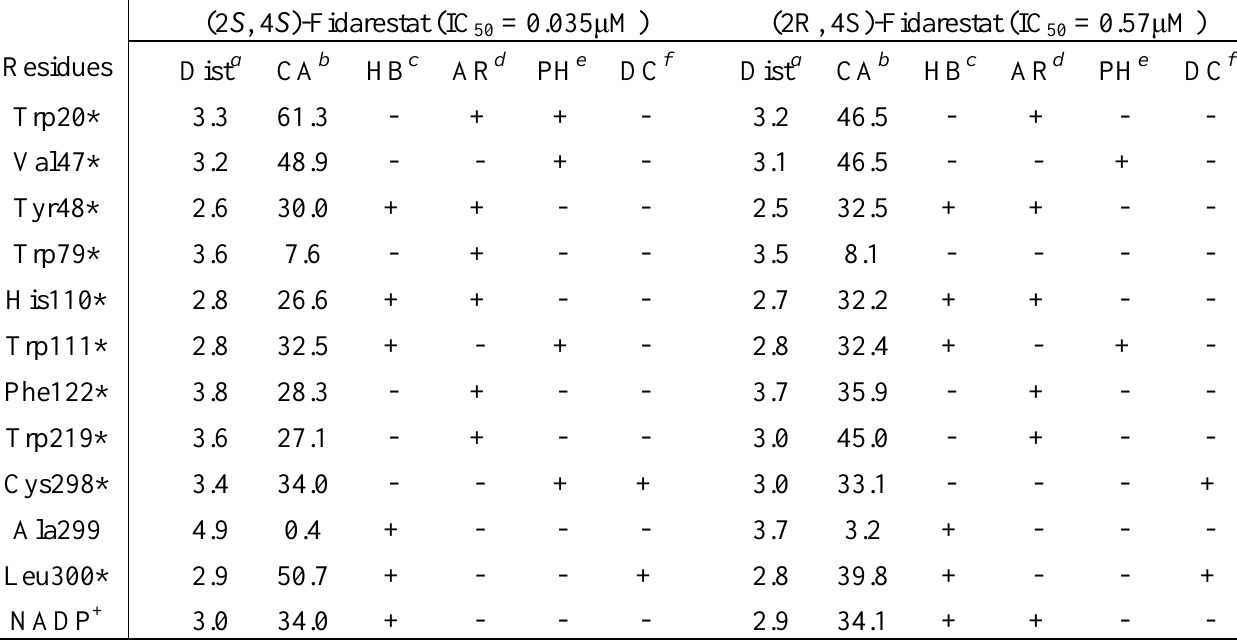
Table 1. Functional residues around (2S,4S)- and (2R,4S)-forms of Fidarestat complexed with Human Aldose reductase (ALR2). In the analysis of interactions, the following geometrical criterion for hydrogen bonds was used: a donor-acceptor distance 2.5 Å and a donor-hydrogen-acceptor angle of at least 135°. The IC50 value is taken from ref. 33.